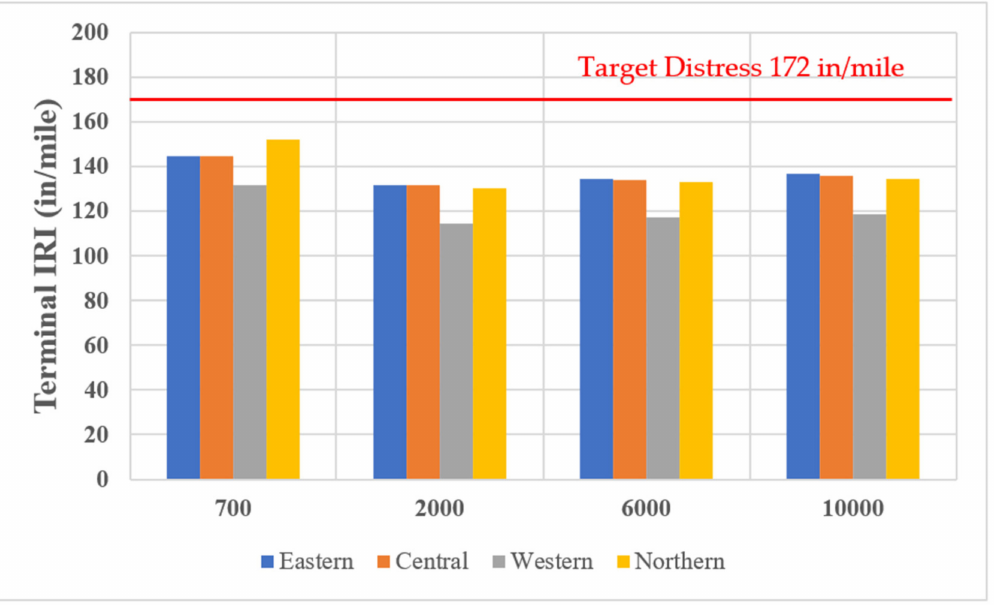
Figure 9. Terminal IRI (in/mile) for all different types of traffic for all the regions for 20 years design